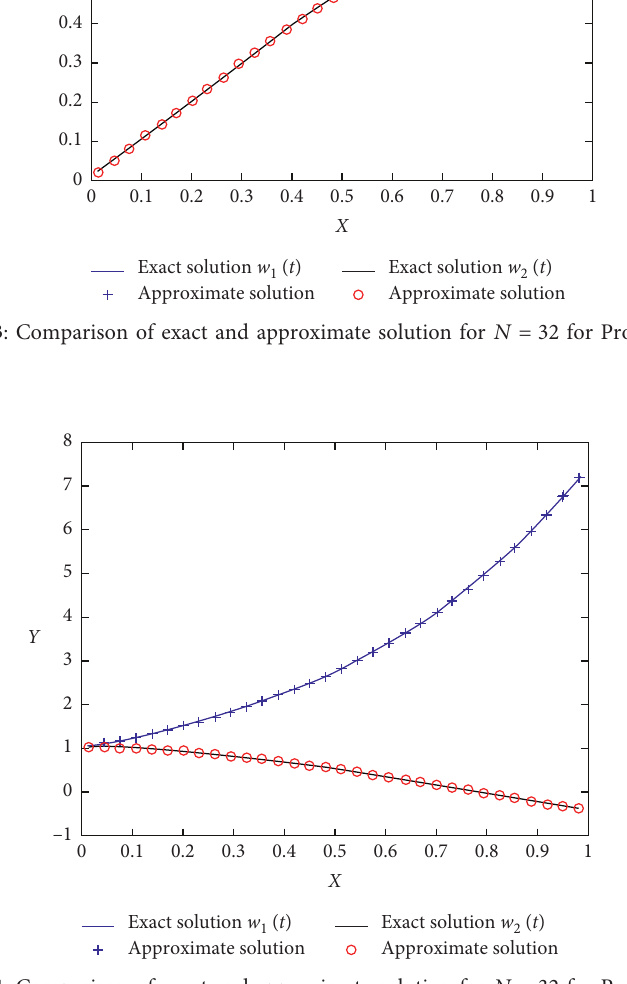
Figure 4: Comparison of exact and approximate solution for N � 32 for Problem